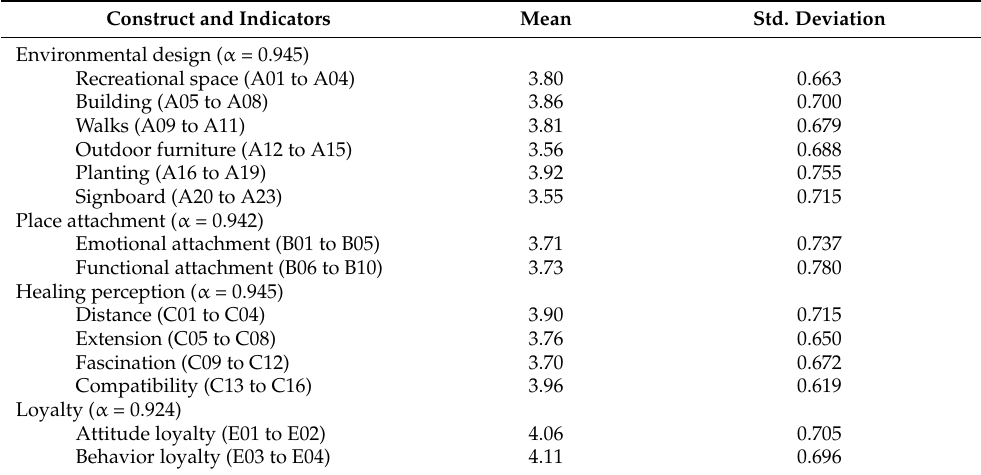
Table 2. Reliability assessment of the